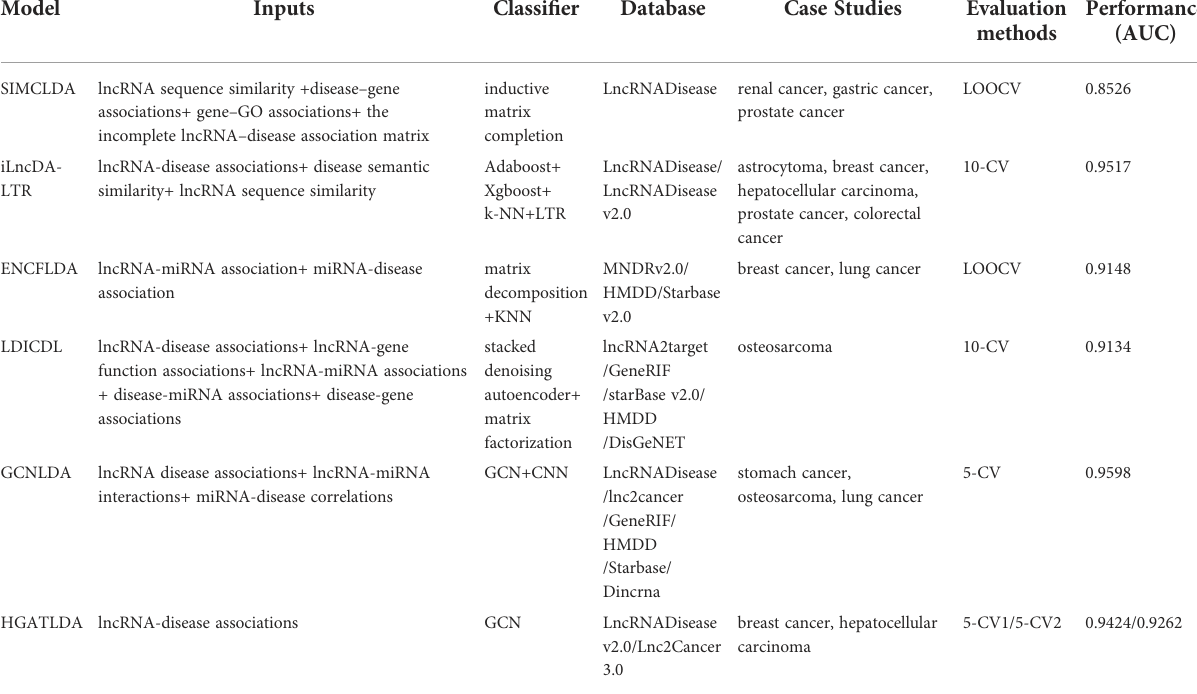
TABLE 1 Machine learning models for predicting lncRNA and disease associations. Model